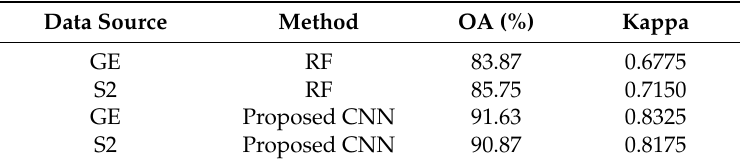
Table 8. Comparison with random forest classification.